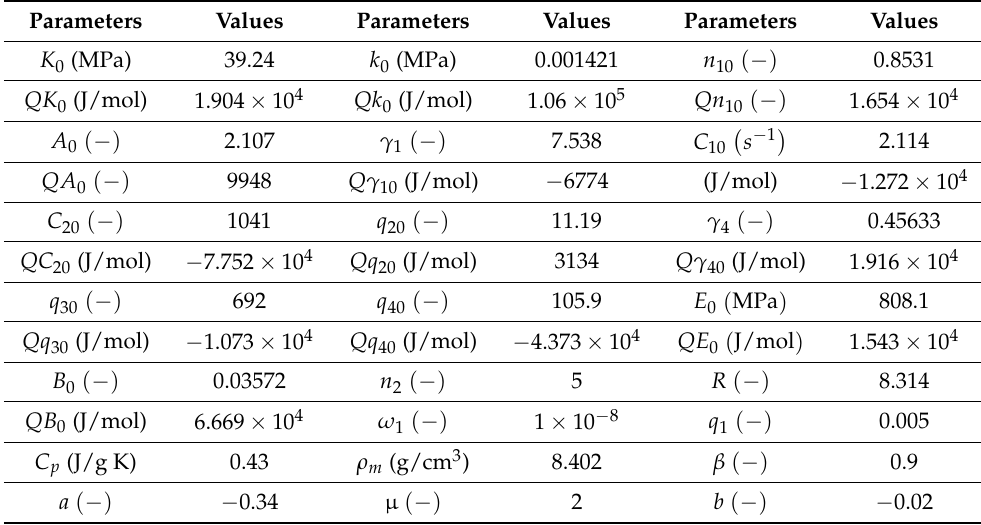
Table 3. The determined constants for unified viscoplastic equation. Parameters Values